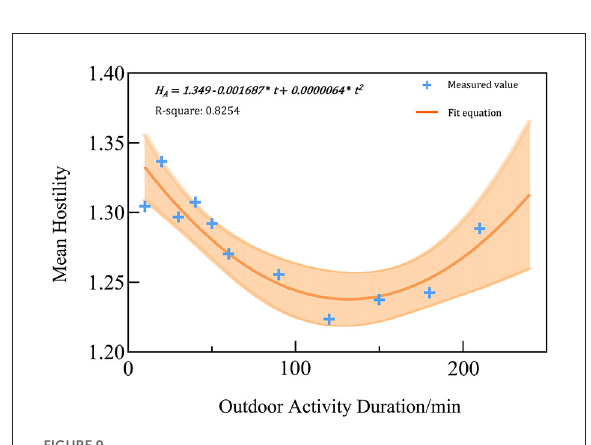
FIGURE9 The trend of hostility with time of outdoor